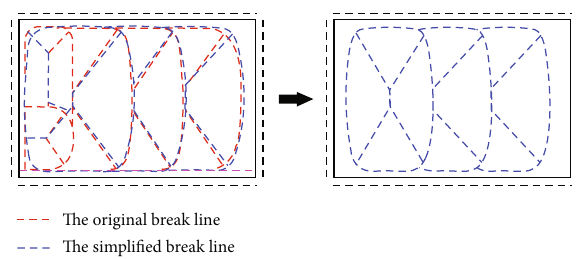
Figure 22: Fracture law of prolonged “ X-O ” fracture.